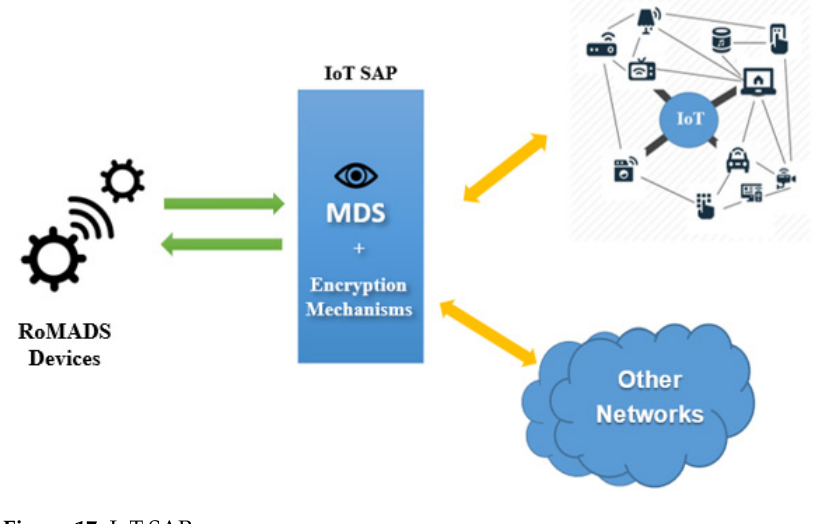
Figure 17. IoT SAP.